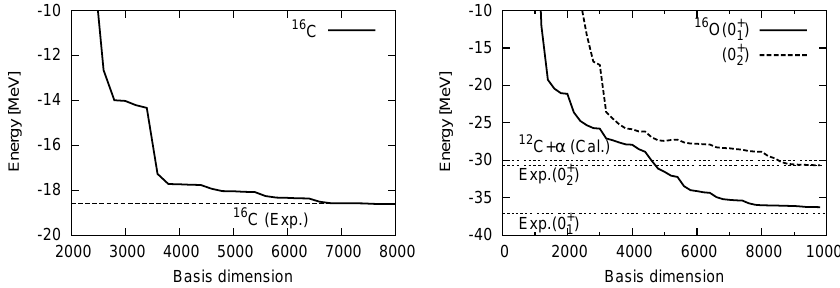
Figure 1. Energy curves for the ground state of 16 C (left) and the ground and excited states of 16 O (right). The calculated 12 C(0 + ) + (cid:11) threshold and experimental energies are shown by thin lines. 1